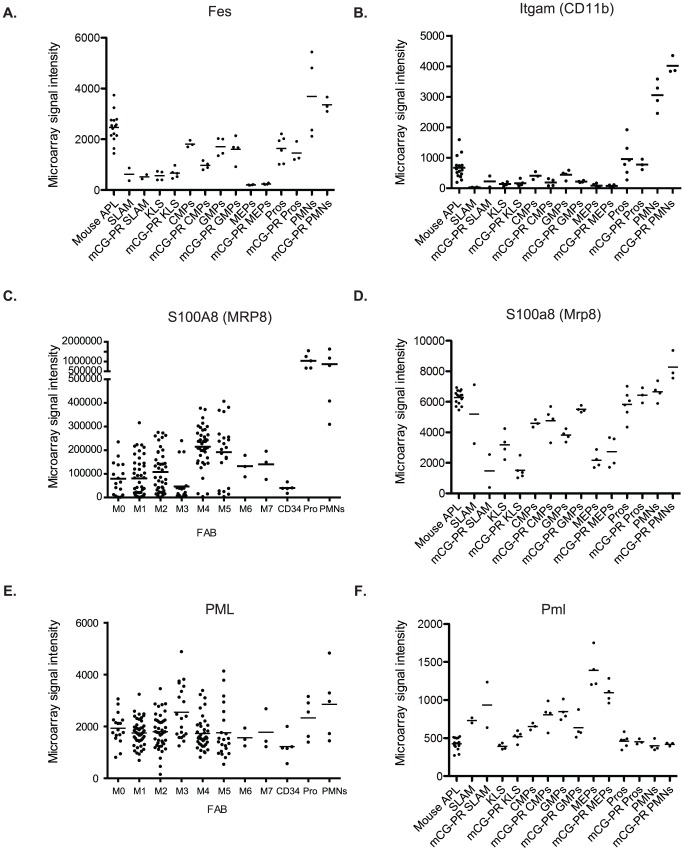
Expression of genes used to target PML-RARA expression in mice.Expression data for the indicated genes in flow-sorted bone marrow cells using murine Affymetrix Exon 1.0ST arrays or Human Genome U133 Plus 2.0 arrays. Each panel is a highly representative probe on the array. A. cFes (probeset 4758608). B. Itgam (CD11b, probeset 4782002). C. S100A8 (MRP8, probeset 202917). D. S100a8 (Mrp8, probeset 5010279). E. PML (probeset 235508). F. Pml (probeset 4885841). We have previously published the expression profile of PML in AML and human hematopoietic cells [11]. Panel E includes an additional 86 AML cases of AML and data from a second representative probe.